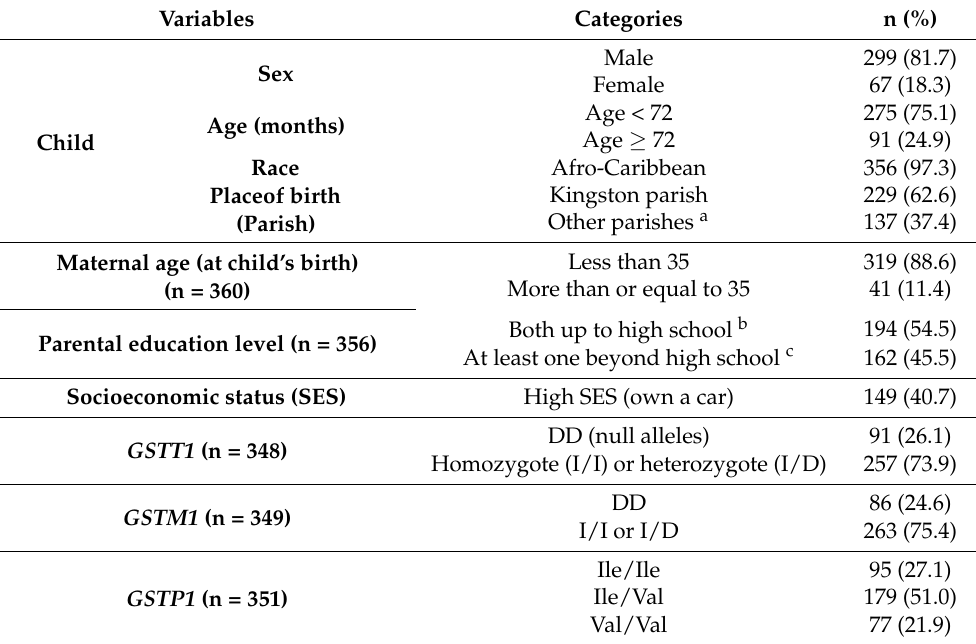
Table 1. Characteristics of typically developing (TD) children and their parents (N =